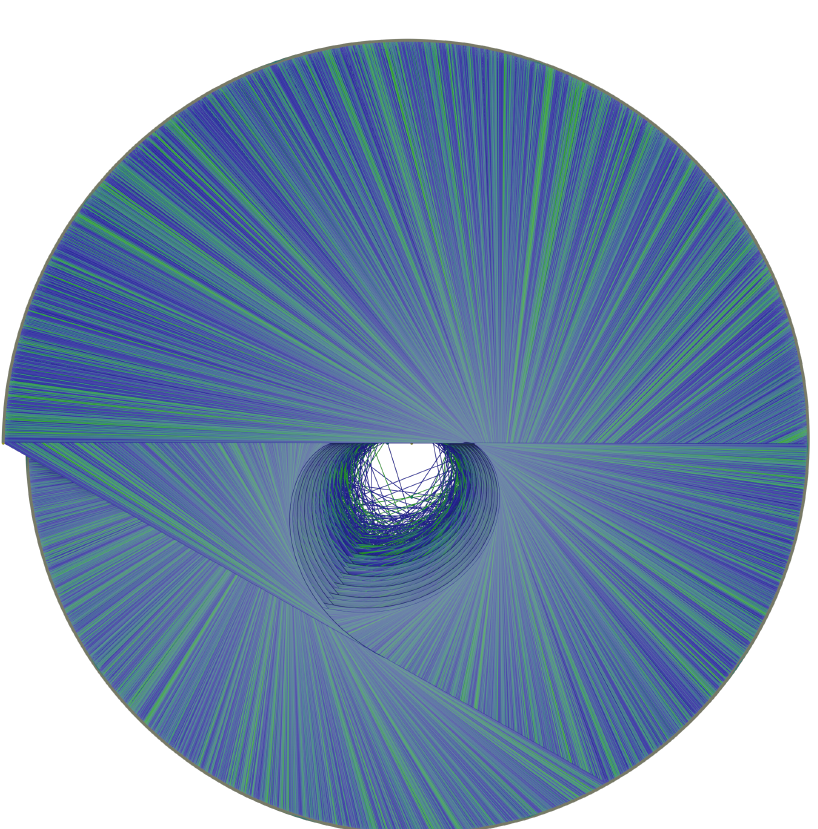
Figure 24. Orthogonal view of the Golden Automaton starting from 1 (blue), which overlaps the one starting from 161 (green). We first observe that the basin of 161 (the first A g of 31) now occupies a much larger proportion of the basin of 1 than did the basin of 1457 (the first A g of 127). Simply put, the more a number diverges, the longer the trail of type A numbers it leaves and the more its basin of attraction inflates, ultimately making a collision with the basin starting from 1 inevitable. (Another important property of Mersenne 31 is that, as defined by OEIS [43], it is “self-contained”, meaning its orbits contains multiples of itself (i.e., the number 155).) This representation of base 3 correlates with the inflation propensity of Collatz orbits is in fact directly scannable, similar to a QR code, with the central truncated caustic forming the standard reference point of the scan and the pseudorandom distribution of the green lines using a direct verification protocol of the Bocart